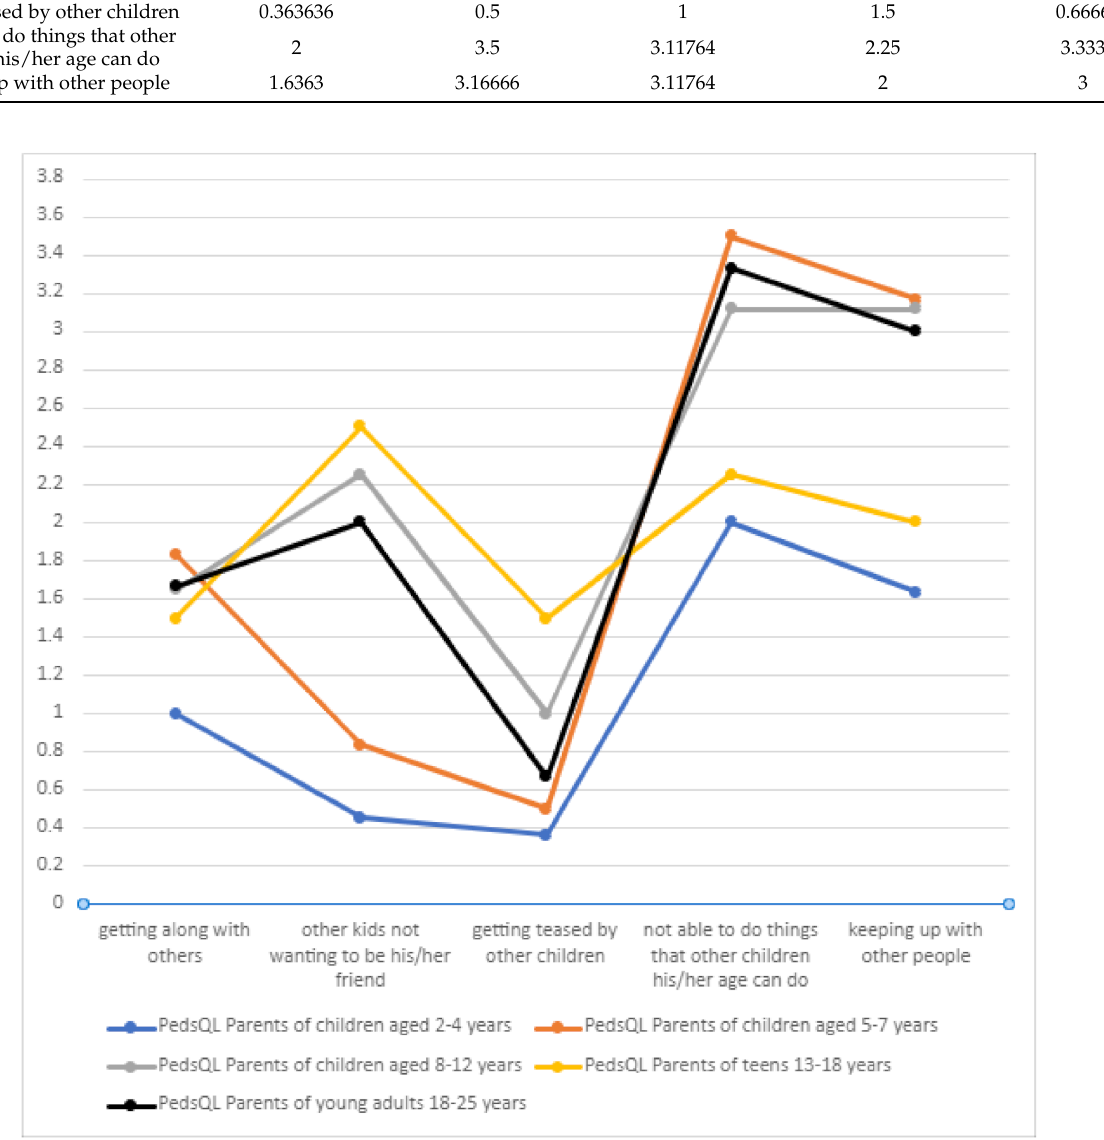
Figure 13. Social functioning of DS patients.